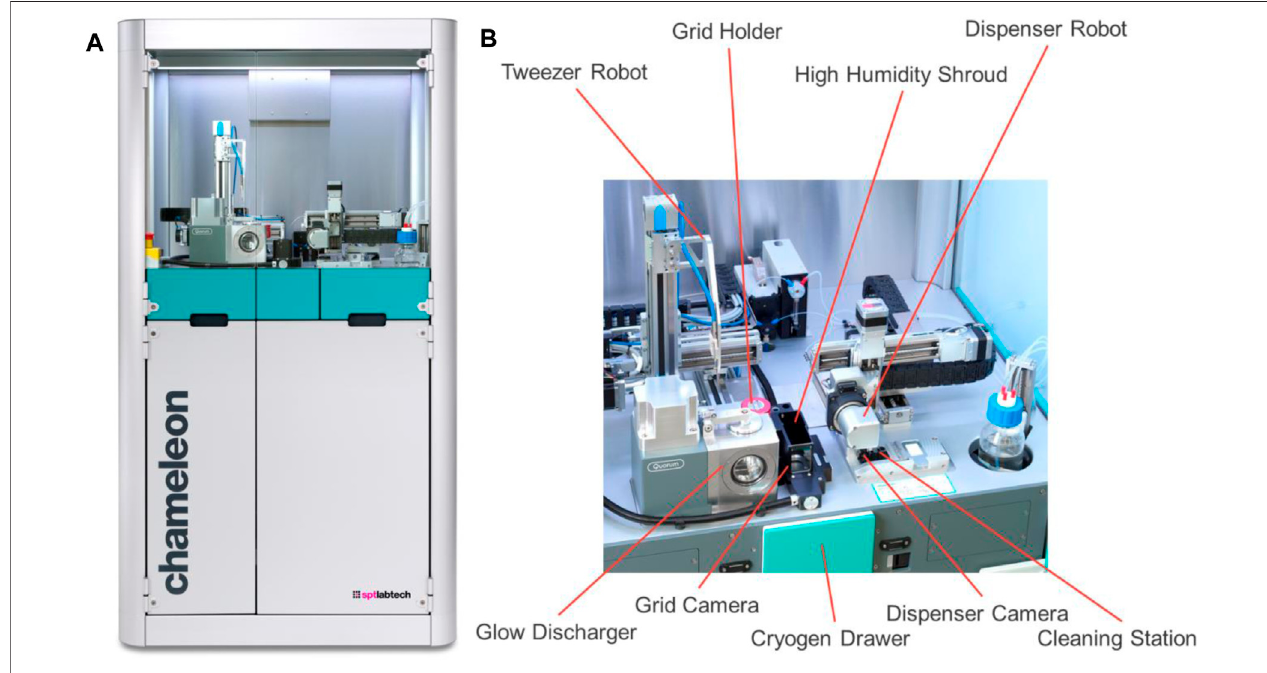
FIGURE1| Overviewofthechameleonsystem. (A) Theentiresystemwiththeroboticequipmentatthetopandthebuilt-incupboardunderneath. (B) Aclose-upof the top deck with the robotic equipment needed for specimen preparation highlighted.